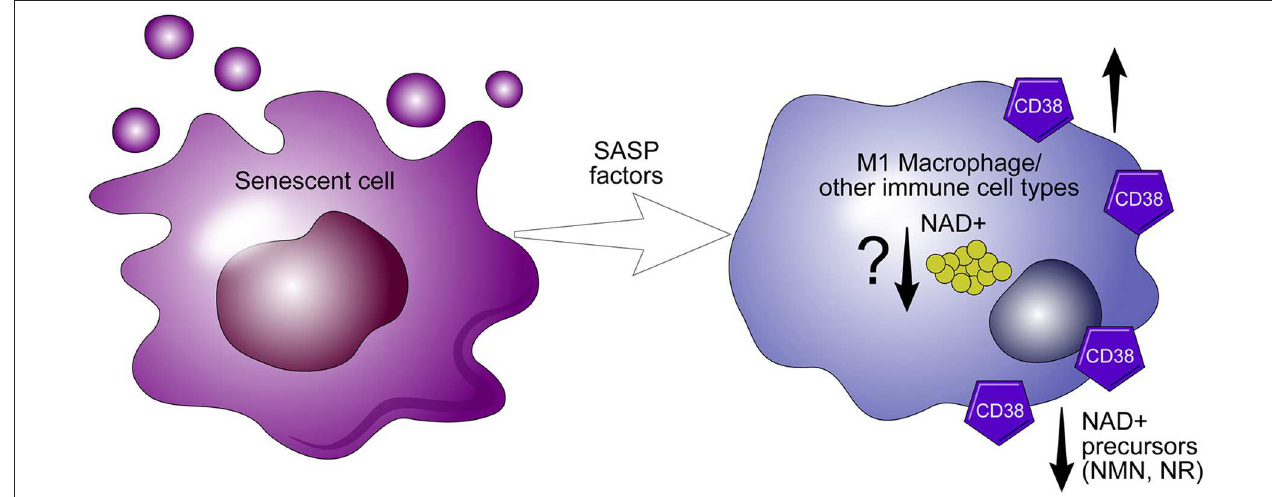
FIGURE 5 | CD38 expression in macrophages mediate “inflammaging.” The senescence associated senescent phenotype (SASP) appears to drive the expression of CD38 in macrophages. During inflammaging, CD38 + macrophages accumulate in aging tissues and potentiate the decline of precursors necessary for NAD +